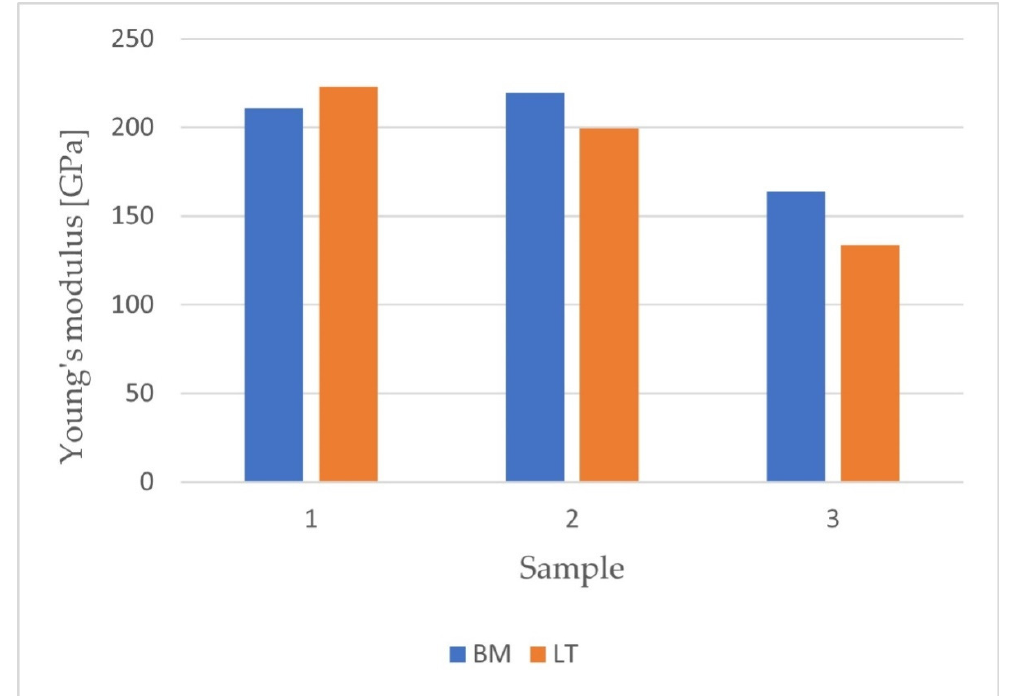
Figure 6. The results for Young’s modulus obtained after nanoindentation tests.